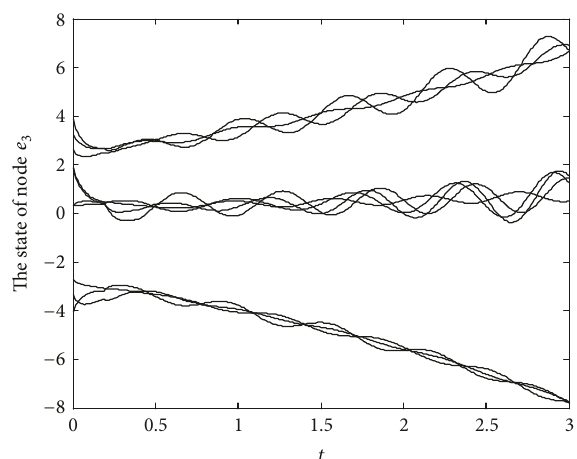
Figure 3: Synchronization error 𝑒 𝑖1 of adding controllers.